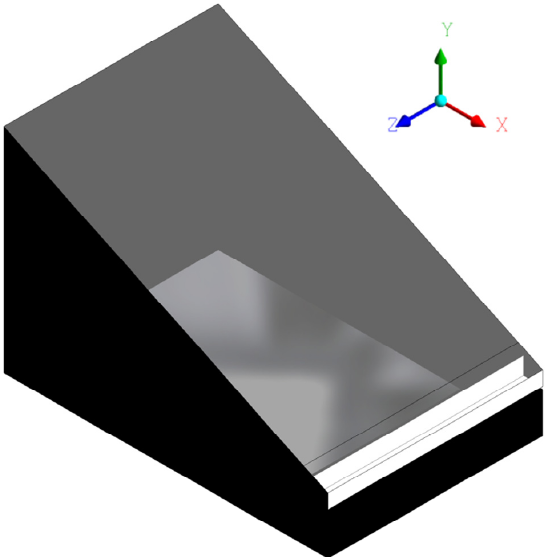
Figure 3. The geometry of the virtual model of the solar still.